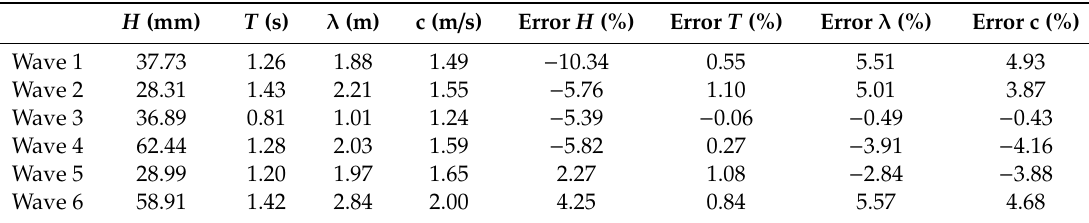
Table 5. Results obtained from the simulations carried out using the LES turbulence model and relative errors with respect to the experimental values of the incident wave.